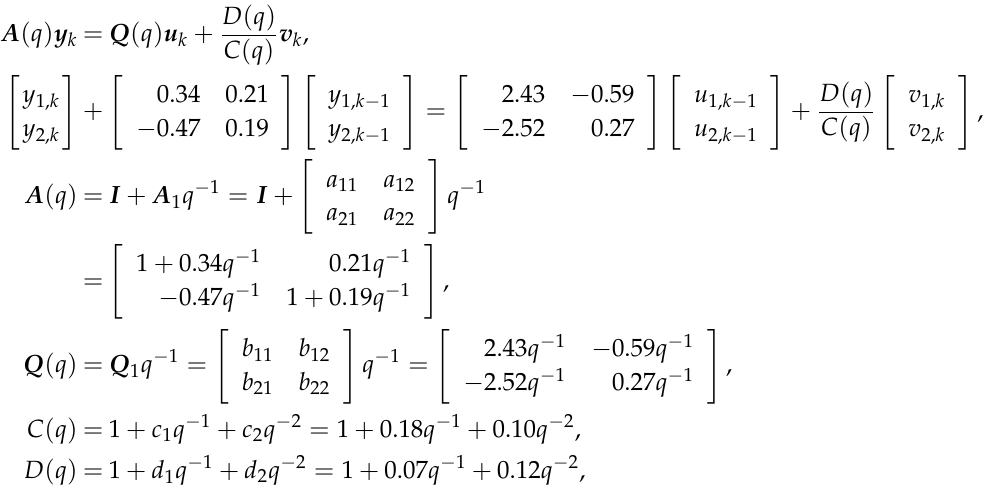
Figure 2. The flowchart of computing the F-M-ML-MIESG estimates ˆ θ i 1, k , ˆ c i , k and ˆ Θ k .